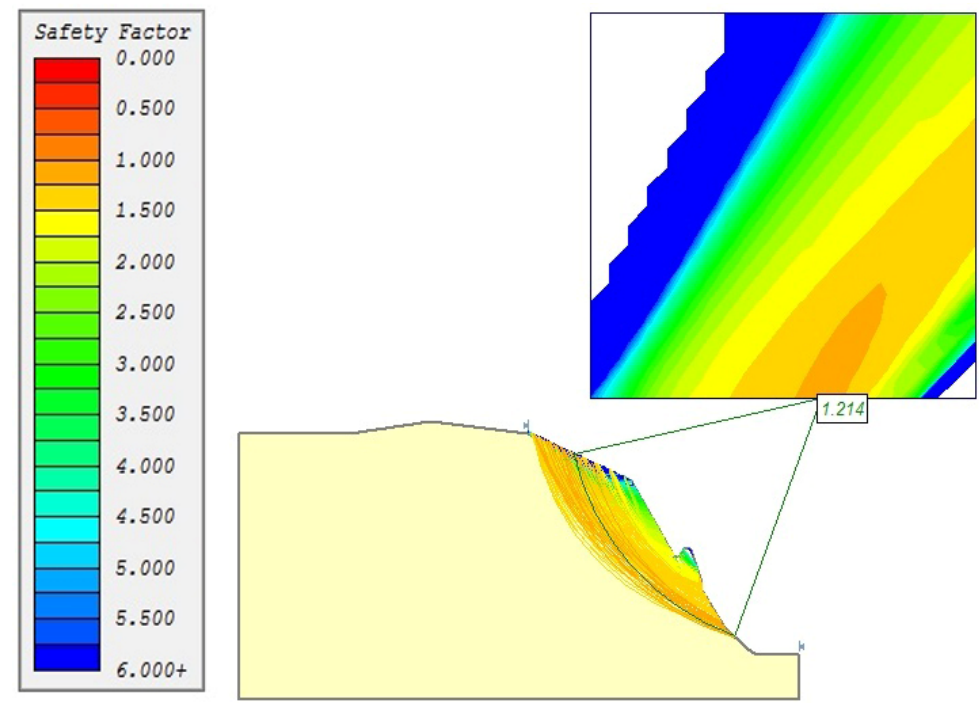
Figure 6. Stability analysis of the selected slope by SLIDE. Table 7. FS evaluation by different models for the selected